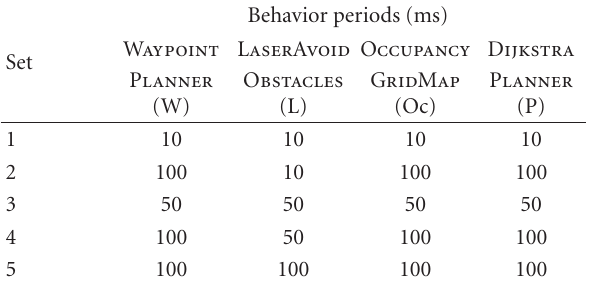
Figure 3: K-team Koala Robot equipped with an ETX-Nano computer for control and a Hokuyo URG laser ranger.